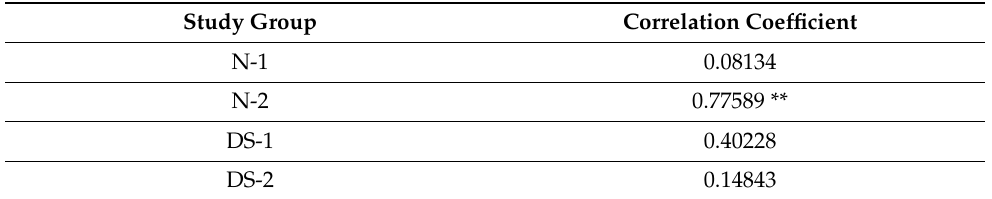
Table 2. Pearson’s correlation coefficient test comparing the salivary histatin 5 to total salivary protein concentration among the